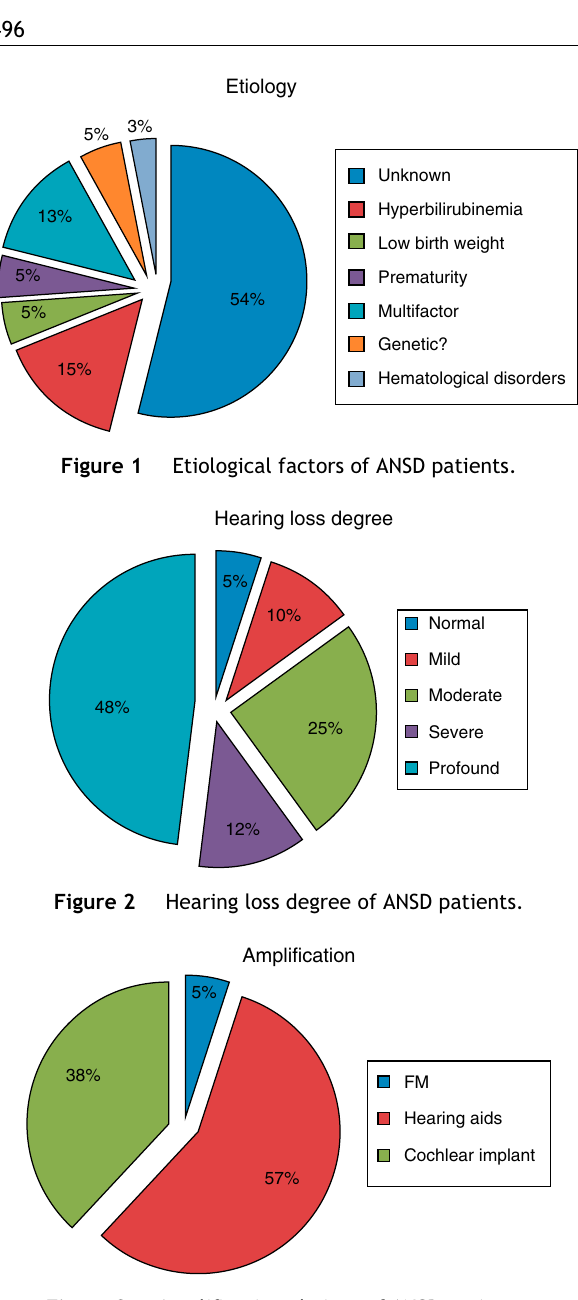
Figure 3 Amplification choices of ANSD patients.